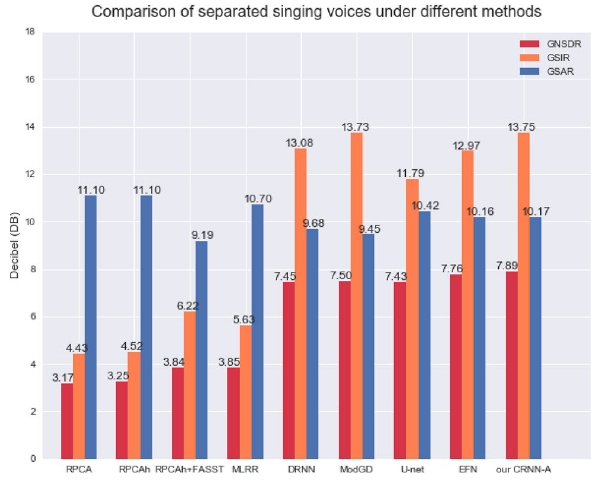
Figure 7. Comparison of singing voice separation under different methods.